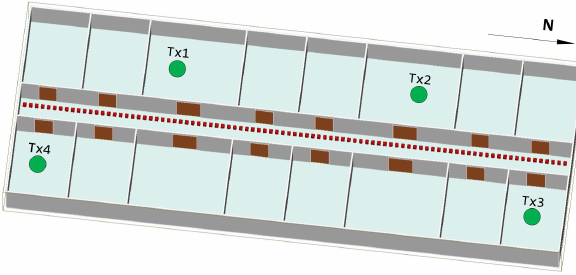
Figure 2: 17 m (cid:2) 46 m test bed with receivers (red) and transmitters (green).